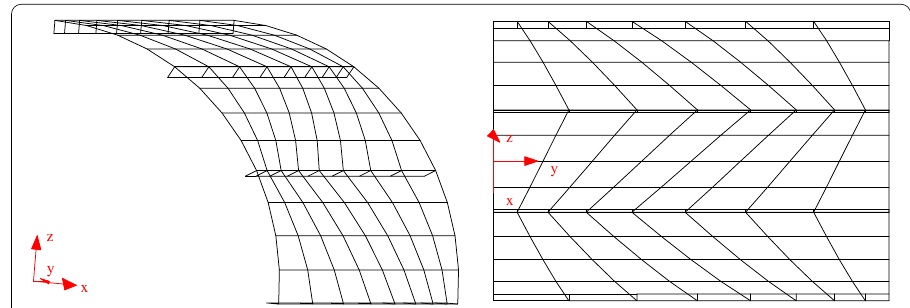
Fig. 38 Distorted finite element mesh (12 × 8 × 1), perspective view (left), view in direction ( − 1 , 0 , − 1) (right)